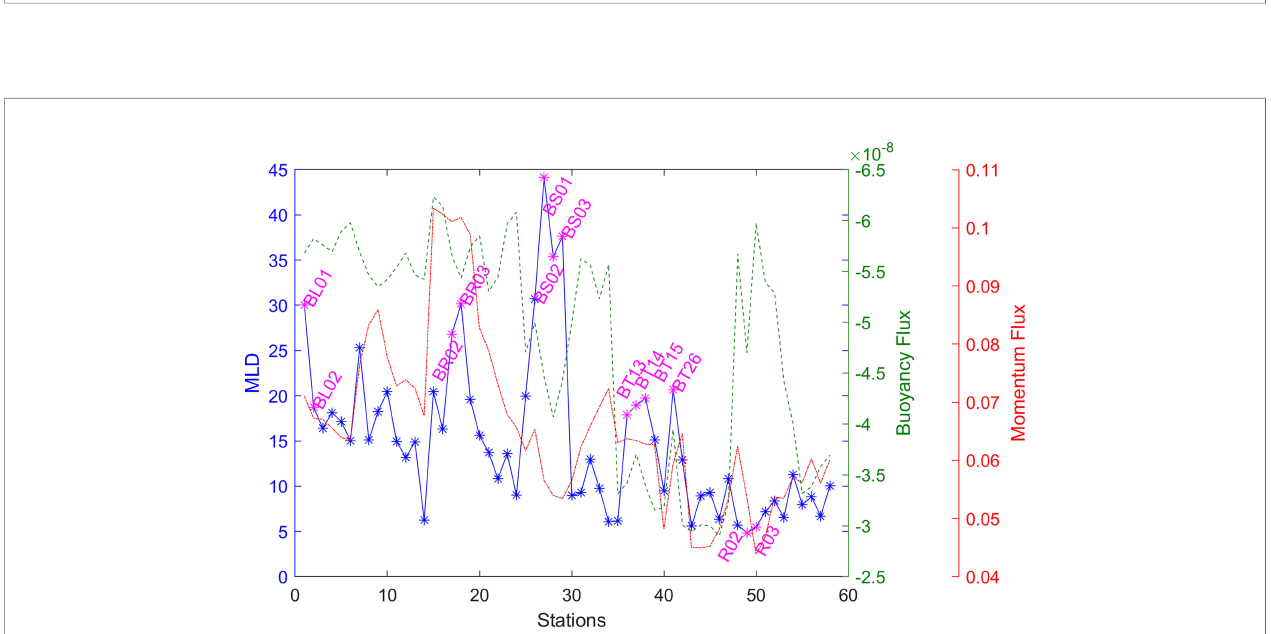
FIGURE 7 | The buoyancy fl ux, momentum fl ux, and MLD of all stations. The buoyancy fl ux and momentum were averaged from July 1 to September 8. The order of stations is the same as in Table S1 in the Supplementary Material II